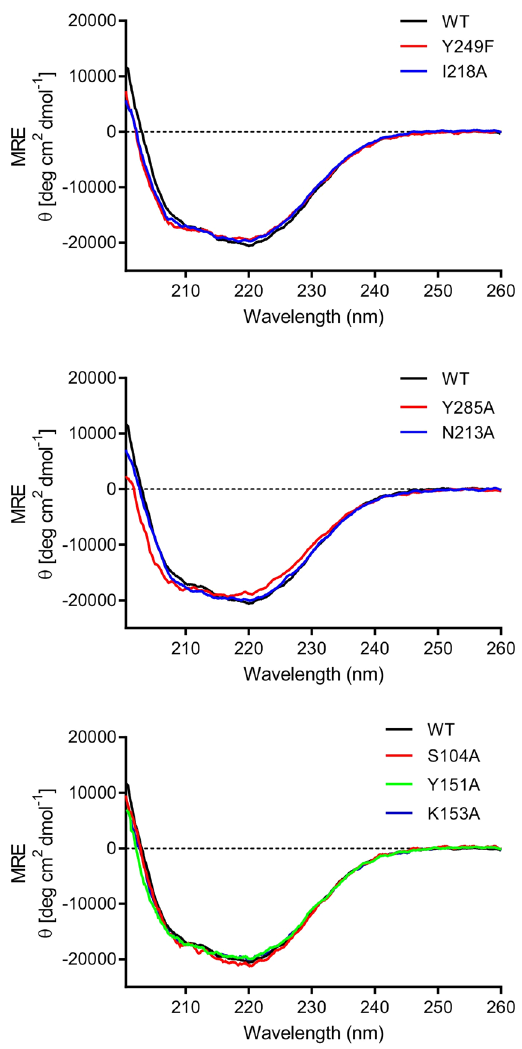
Figure 6. CD spectra of native TlpC LBD (WT) and its S104A, Y151A, K153A, N213A, I218A, Y285A and Y249F